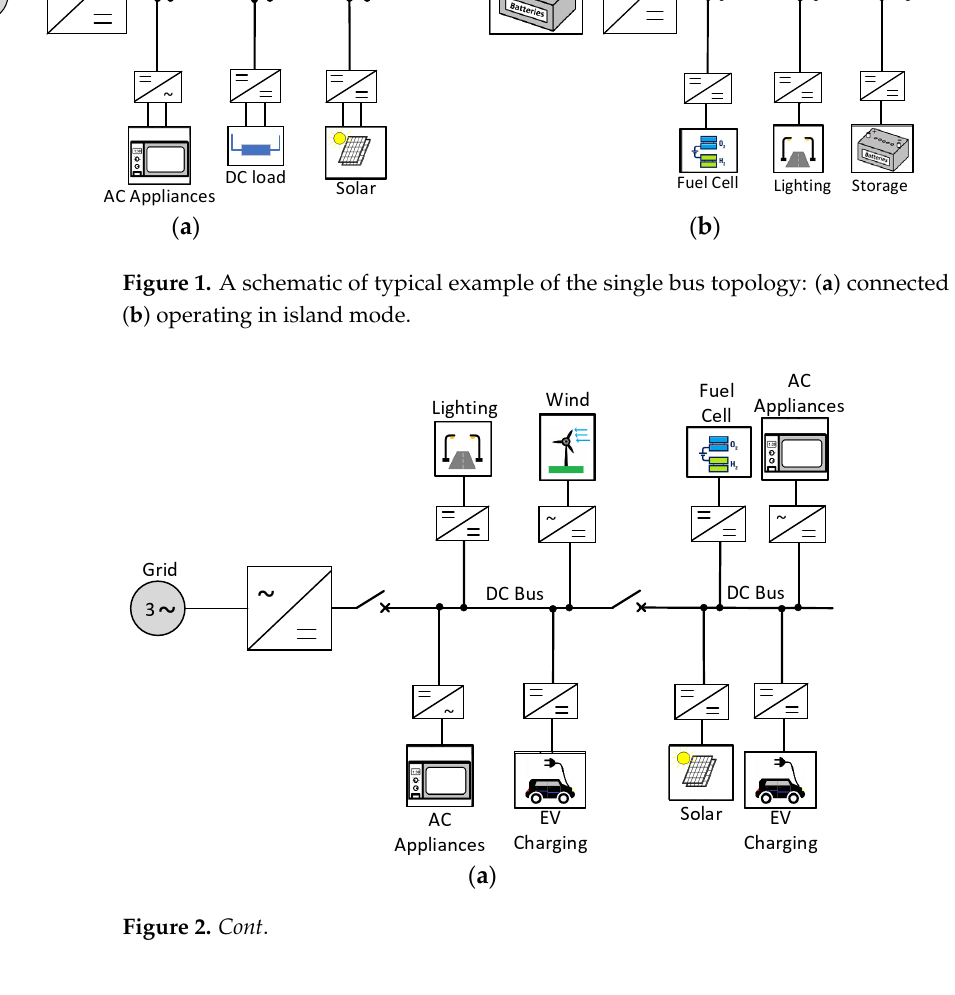
Figure 1. A schematic of typical example of the single bus topology: ( a ) connected to the grid and ( b ) operating in island mode.